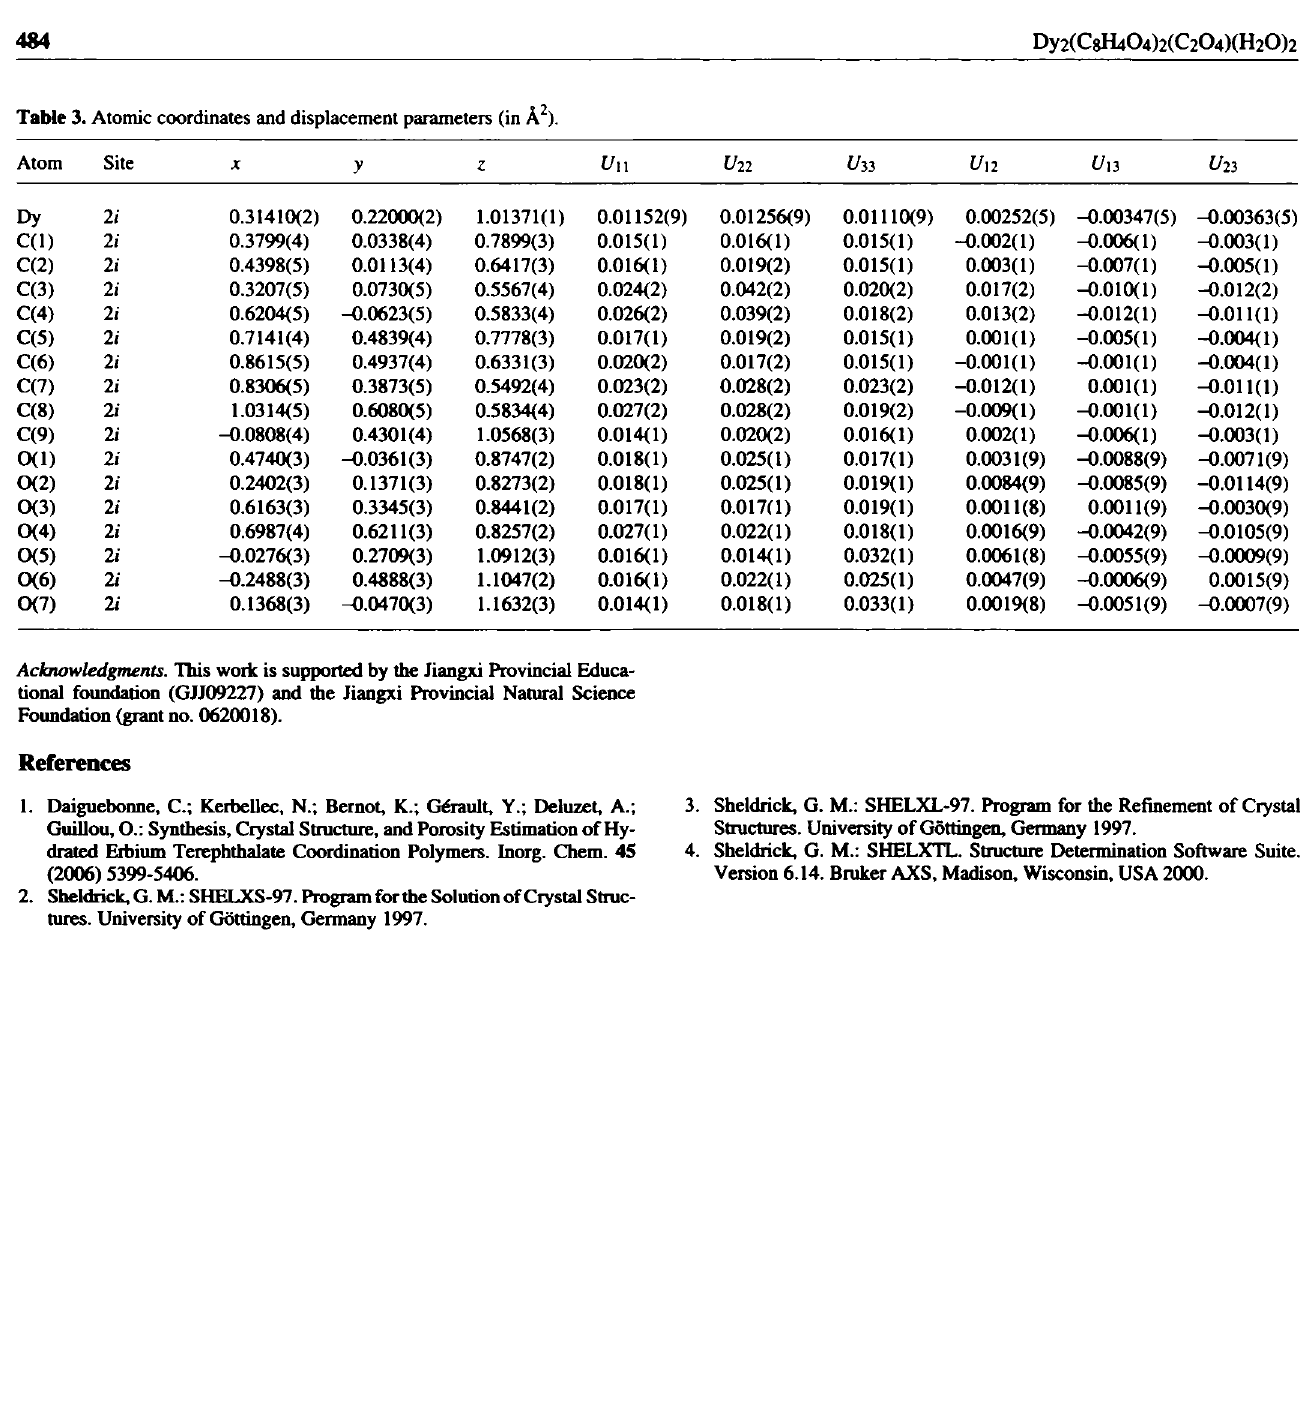
Table 3. Atomic coordinates and displacement parameters (in Â 2